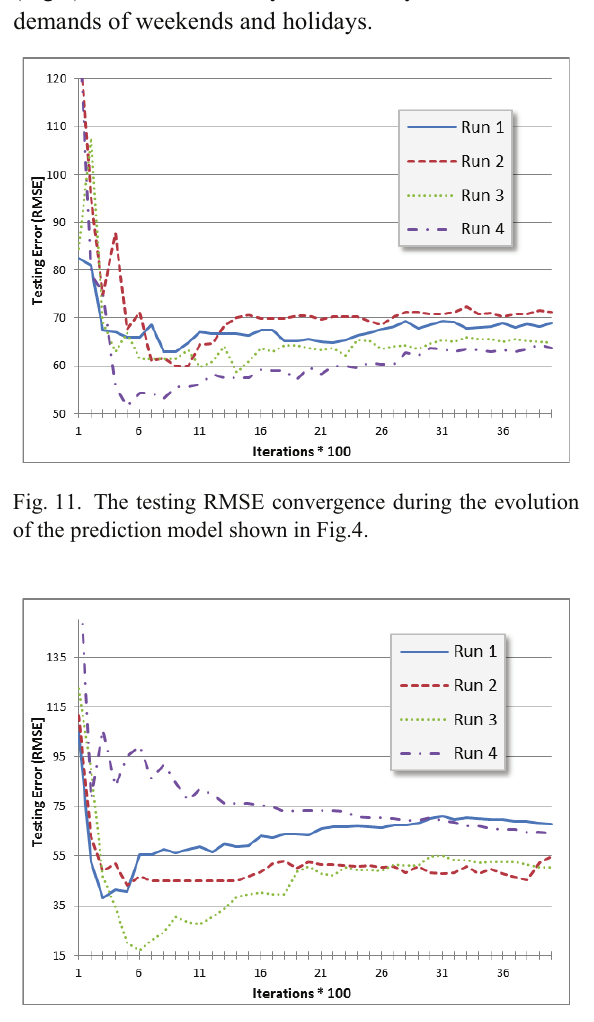
Fig. 12. The testing RMSE convergence during the evolution of the prediction model shown in Fig.6.